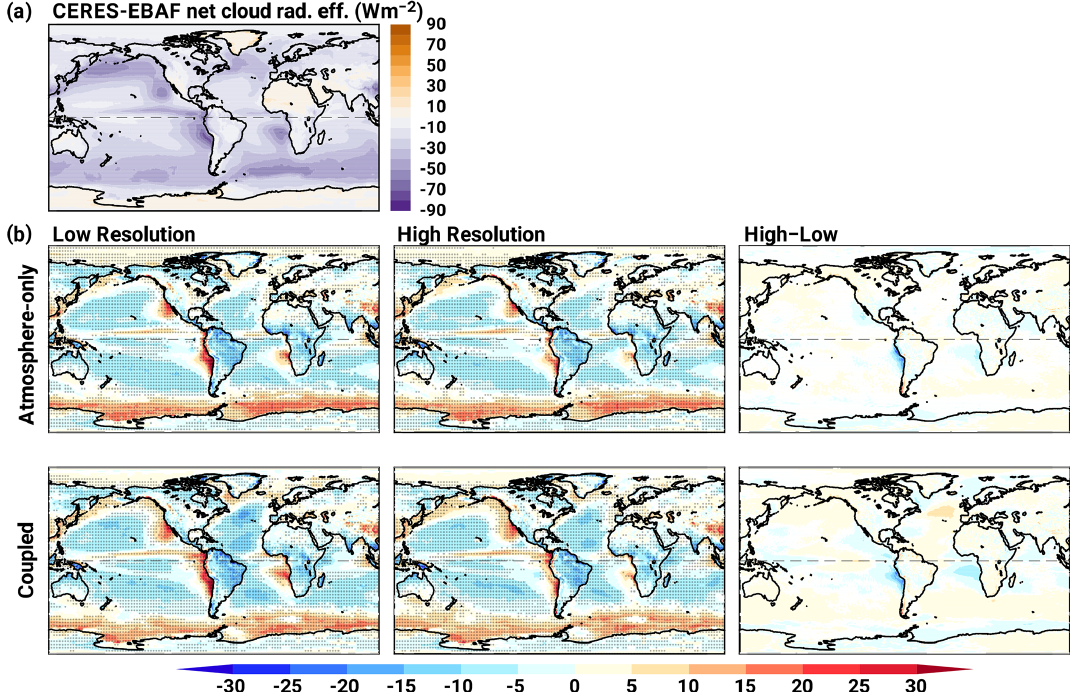
Figure 5. (a) CERES-EBAF net cloud radiative effect (in Wm − 2 ). (b) Multi-model ensemble mean bias in net cloud radiative effect (in Wm − 2 ) with respect to CERES-EBAF at low and high resolution (left and middle) and differences between the two resolutions (right), as in Fig. 1.